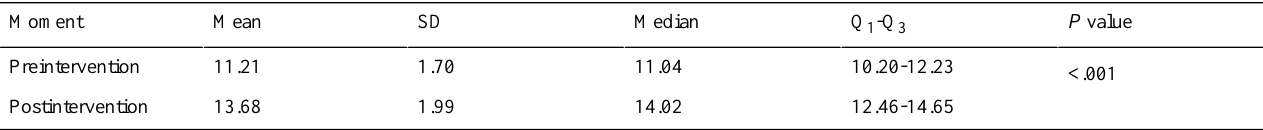
Table 2. Descriptive measures of the scores obtained in the nine domains of the questionnaire designed to analyze the level of knowledge on breast cancer applied before and after the educational intervention, according to the paired Wilcoxon